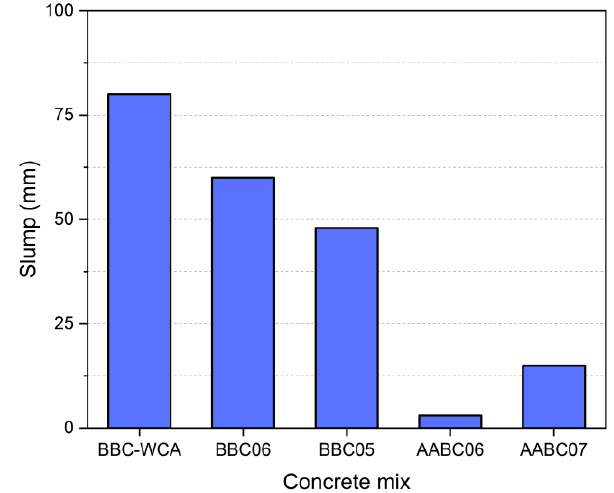
Figure 6. Consistency in the fresh state for each concrete mixture measured in terms of the slump